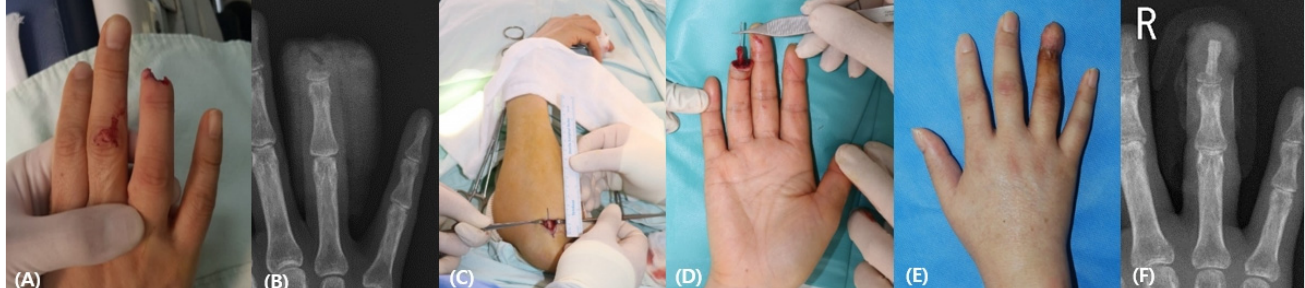
Figure 4. ( A ) A 50-year-old woman experienced a crush injury of the right fourth finger below the lunula. The stump was crushed without bony framework. ( B ) Preoperative X-ray finding. ( C , D ) The olecranon bone was harvested, and an autologous bone graft was performed with a k-wire. ( E ) Postoperative photographic finding 6 months after the operation ( F ) Postoperative X-ray finding.